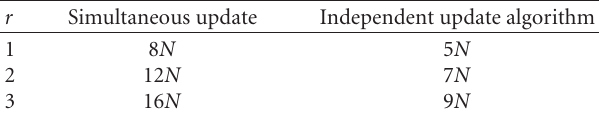
Table 2: Comparison of multiplication operations